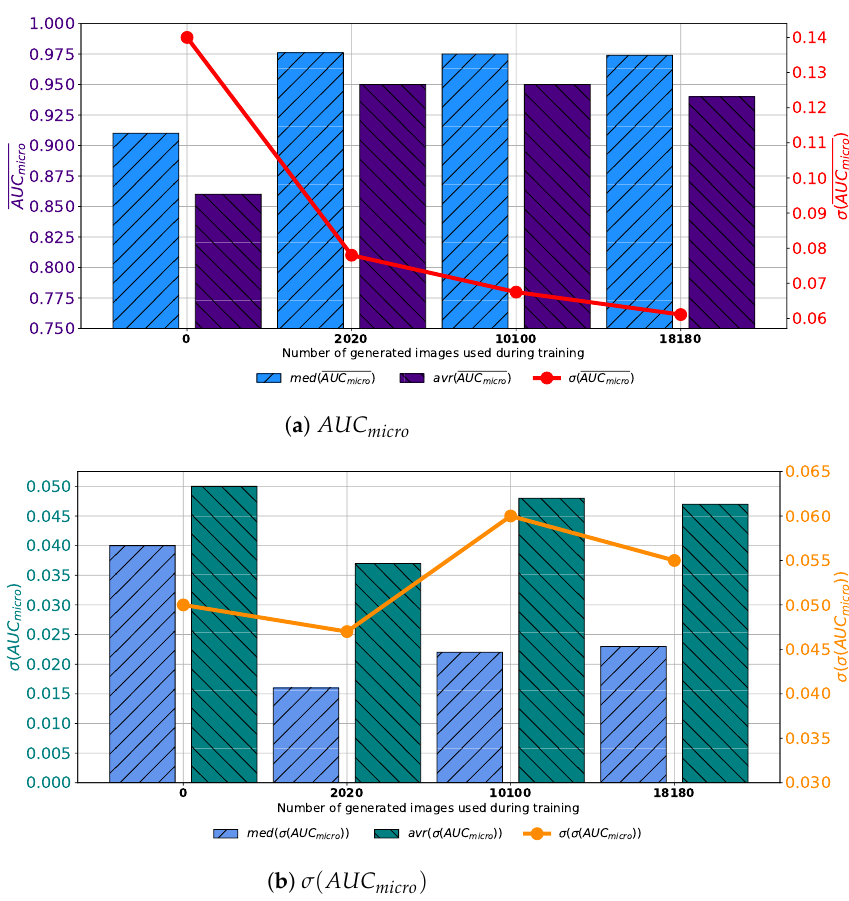
Figure 10. Median, average AUC micro and standard deviation of AUC micro and σ ( AUC micro ) for the case of AlexNet trained with images generated by GAN in 1000